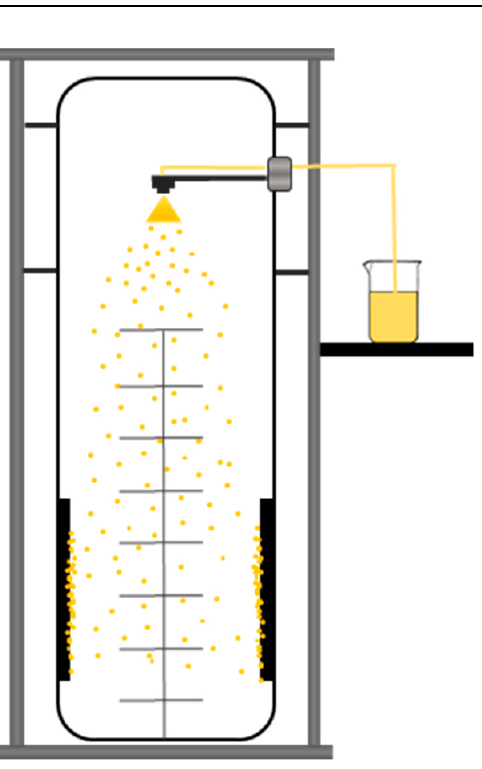
Figure 1. Schematic image of BÜCHI Nano Spray Dryer B-90 HP .